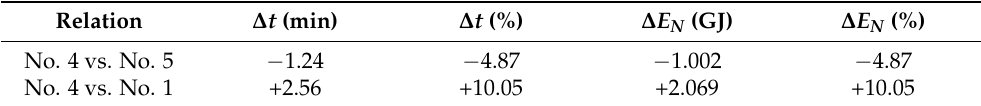
Table 5. The numerical and percentage difference between the flight duration and the energy consumption during the flight on the most sustainable trajectory (No. 4) in relation to the reference trajectory (No. 5) and to another determined trajectory No. 1 (trajectory No. 4. = 100%) on the Copenhagen–Gdansk